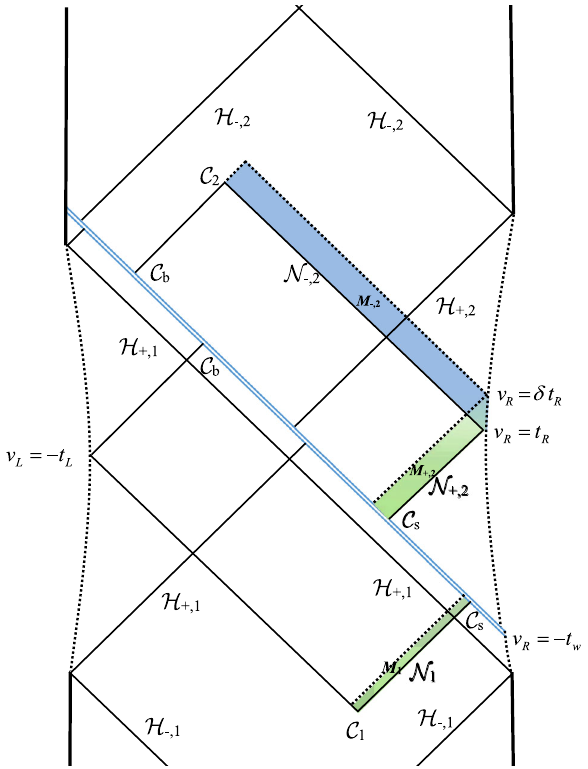
Fig. 1 Wheeler–DeWitt patch of a multiple Killing horizon black hole which is equipped with a thin shell of null fluid collapse, where the dashed lines denote the cut-off surface at asymptotic infinity, satisfying the asymptotic symmetries